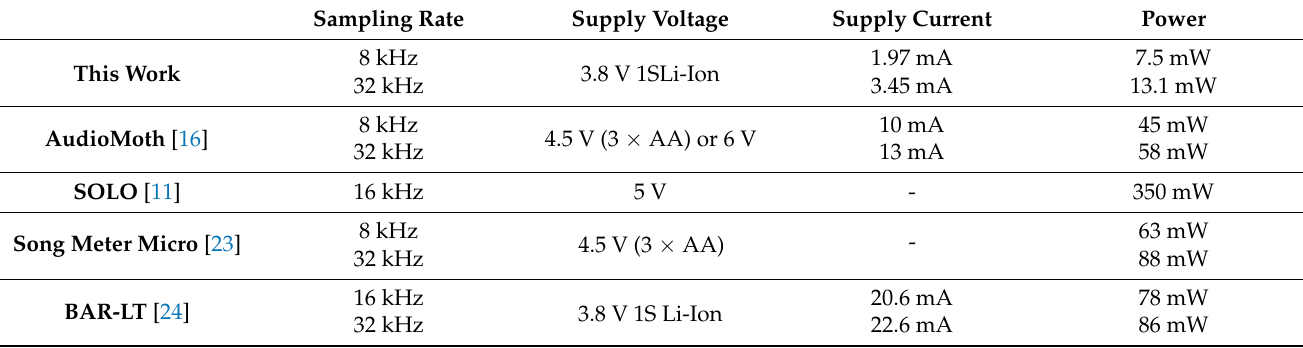
Table 6. Average power consumption of commonly deployed audio recording